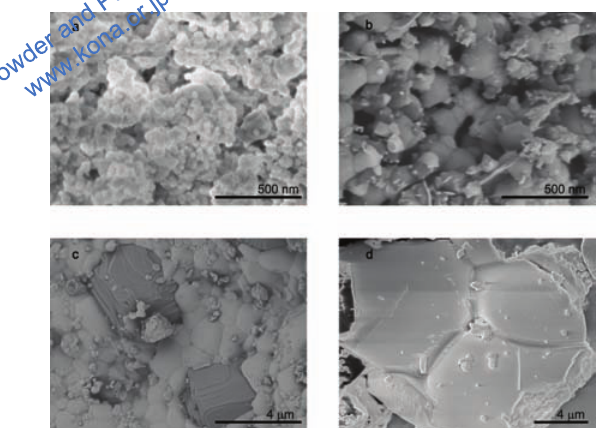
Fig. 3 SEM micrographs of sodium yttrium fluorides prepared by the flame-spray method. (a) and (b) show highly anisotropic hexagonal nanopar- ticles of NaYF : Yb, Tm and Yb, Er, respectively. 4 (c) and (d) show images of micron-sized crystal- lites of NaYF and cubic Y O , respectively, after 4 2 3 sintering at 700 ℃ in ambient atmosphere.